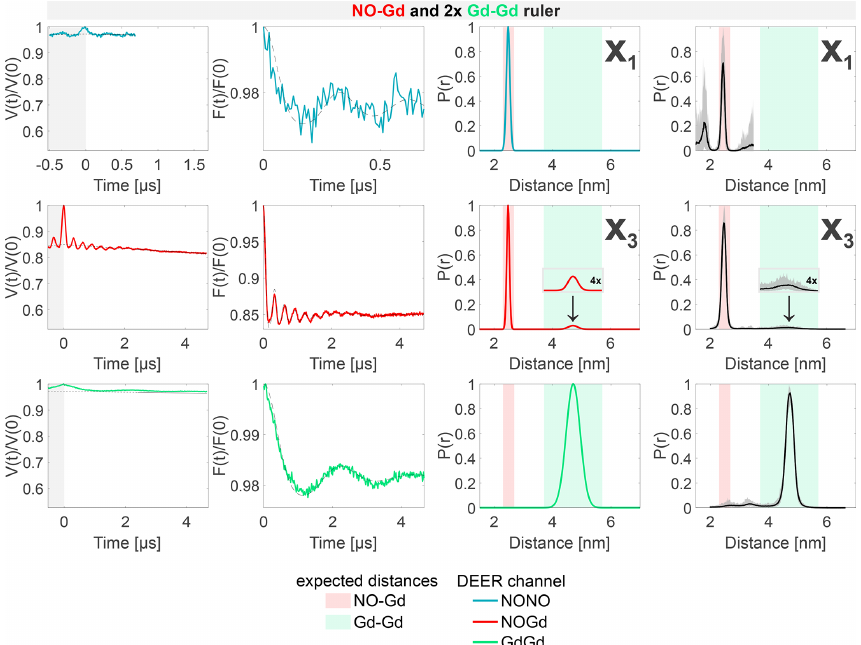
Figure 7. Sample containing the NO–Gd and the Gd–Gd rulers mixed in a 1 : 2 molar ratio. The legend is the same as in Fig. 4. The NONO DEER channel contains a NO–Gd crosstalk signal ( X 1 ), and the NOGd channel contains a Gd–Gd crosstalk signal in presence of a NO–Gd distance designated as X 3 . A comparison of how different neural networks fit this crosstalk signal is shown in Fig. S9b (part